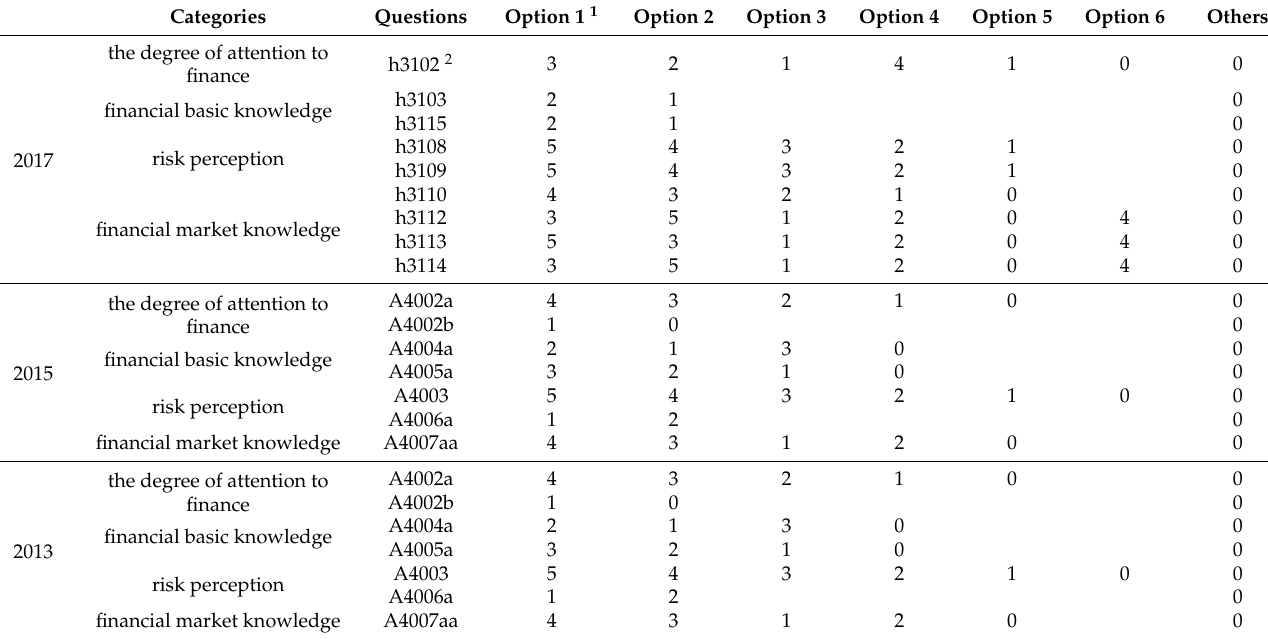
Table A1. Scoring